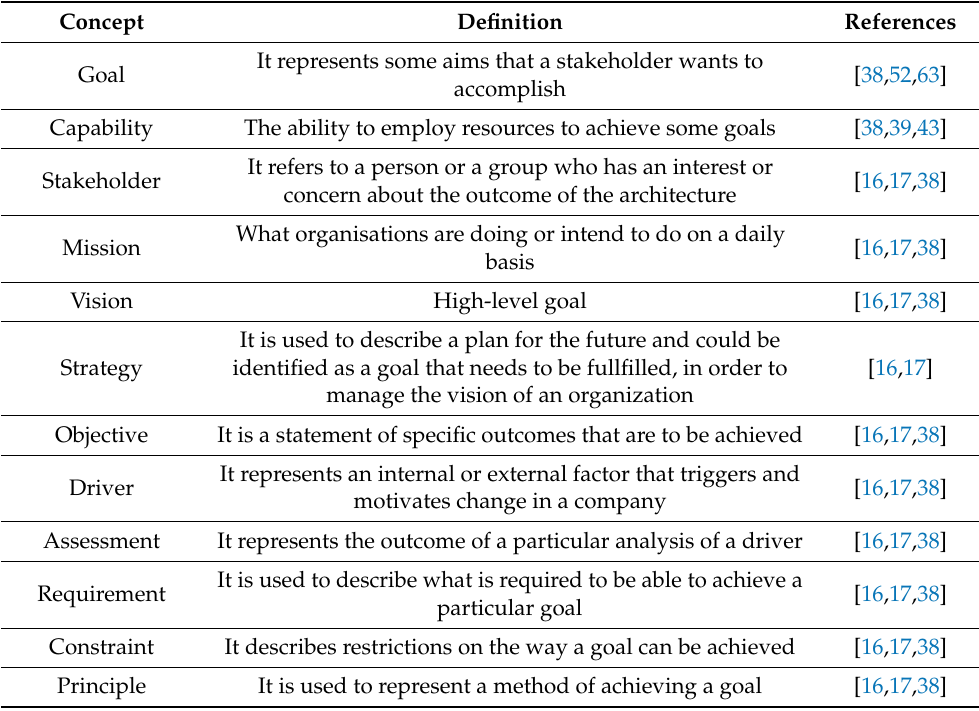
Table 1. Summary of the basic concepts of strategic management in ArchiMate.